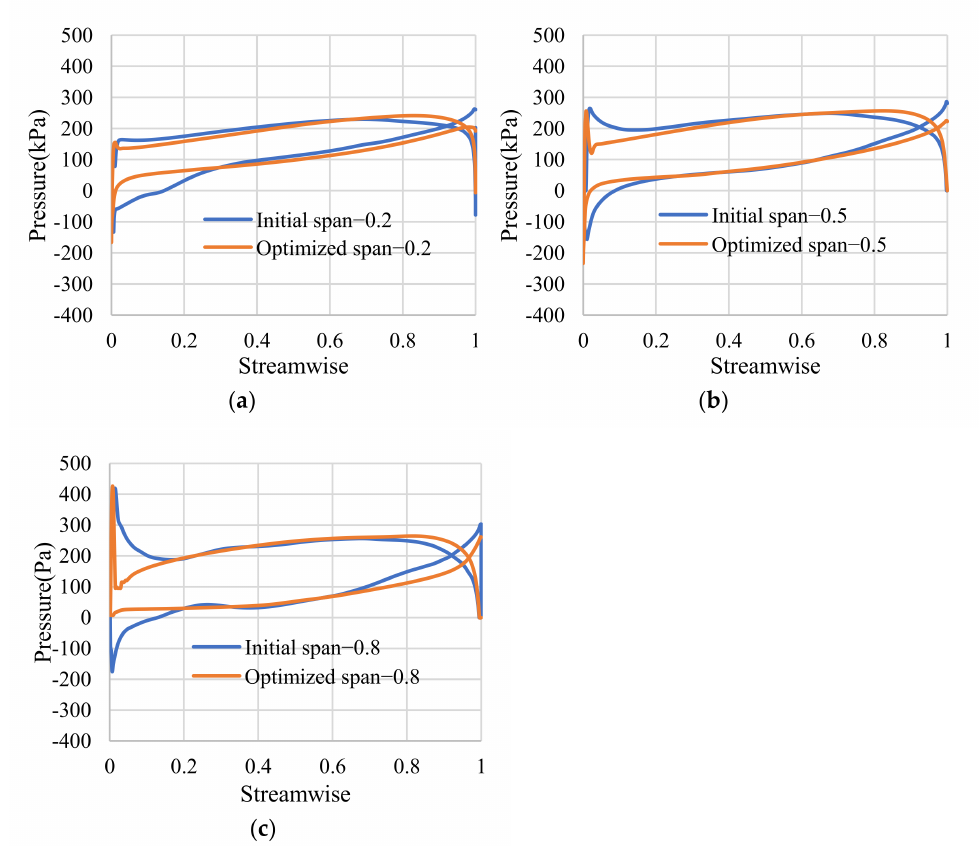
Figure 16. Distribution of blade loading. ( a ) Span = 20%. ( b ) Span = 50%. ( c ) Span =